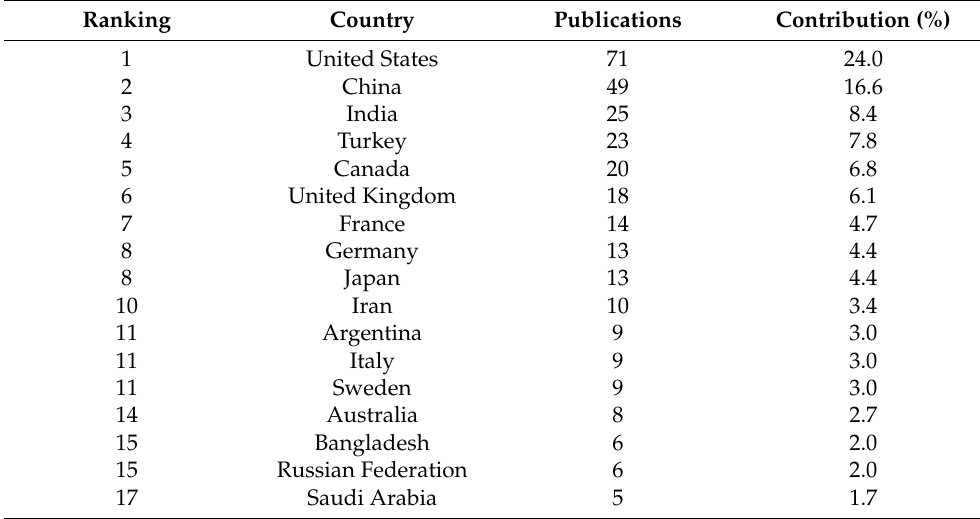
Table 2. The top 17 most productive countries (at least five documents).